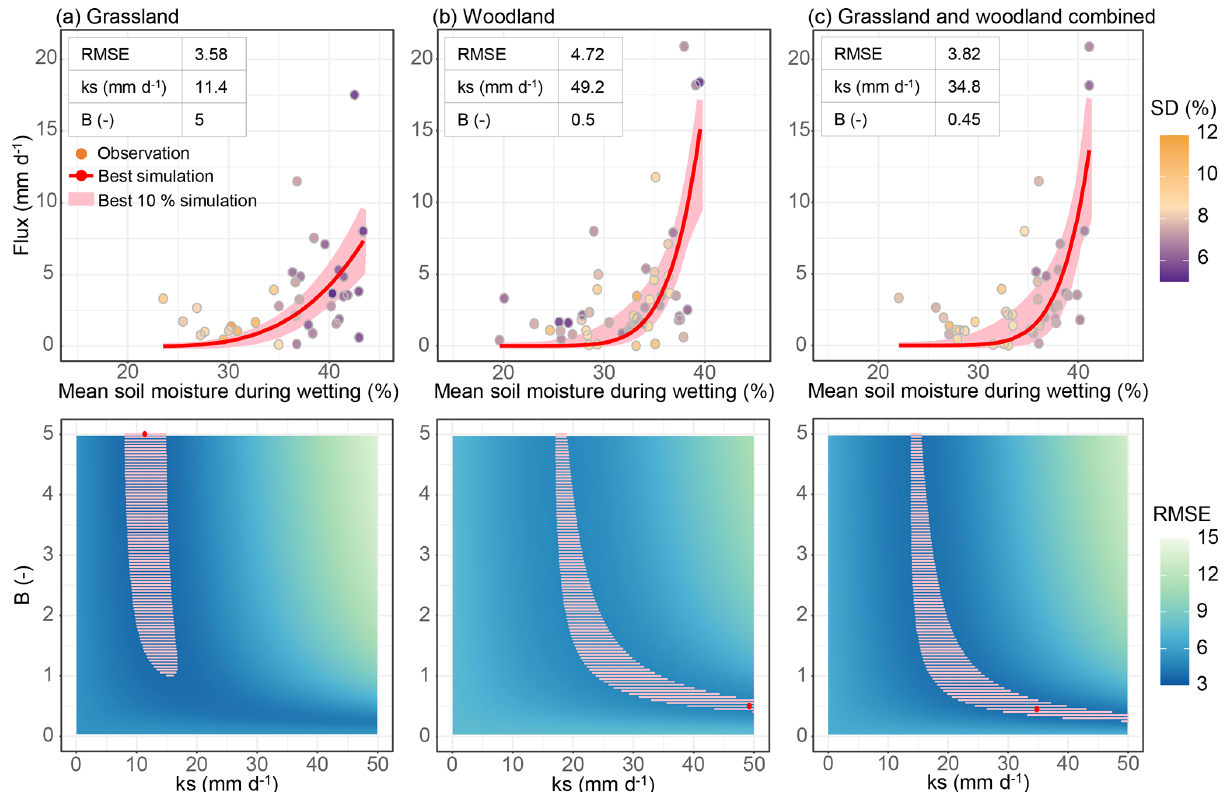
Figure 7. Results of the Monte Carlo parameter calibration of the drainage model for grassland (a) , woodland (b) , and the combined areas (c) . The best simulation is the one presenting the lowest RMSE. Upper panels: the observed fluxes as a function of the soil moisture during the wetting period for each event (points) coloured by the standard deviation of mean soil moisture during the wetting period (SD) and the simulated fluxes (red line) using the drainage model with the fitted parameters. Lower panels: the RMSE of the drainage model for different combinations of k s and B parameters tested in the Monte Carlo calibration procedure, the 10% lowest RMSE (dashed pink), and the k s and B parameters with the lowest RMSE (red